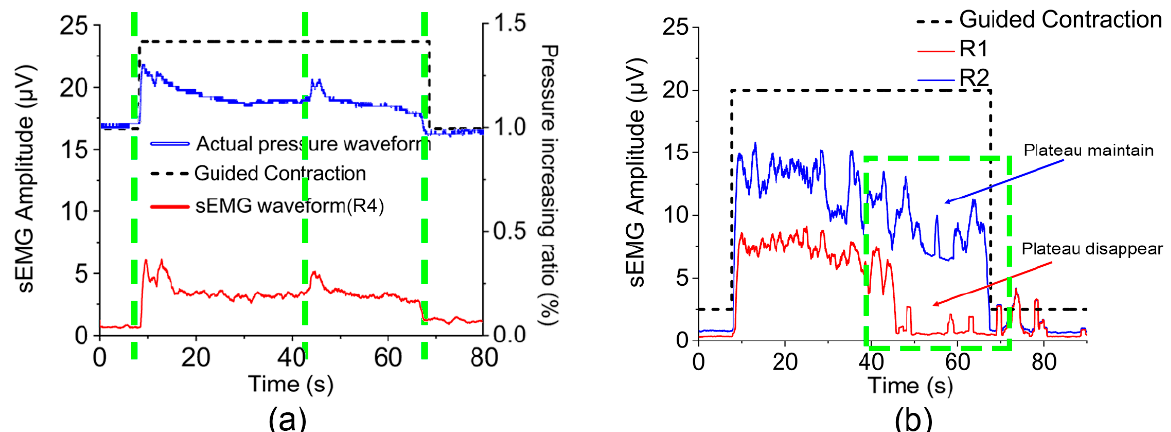
Figure 3. ASEA real-time waveform acquisition. The black dotted line represented the guided reference endurance contraction action. ( a ) Synchronous air pressure, MC-sEMG signal acquisition (by a participant in group A). The red line represented the sEMG signal collected in R4 region, and the blue line represented the air pressure signal. The green dotted line shows the time sequence con- sistency and details coincidence of sEMG signal and air pressure signal. ( b ) The sEMG waveform differentiation of endurance contraction of nearby muscle regions (by a participant in group B). The